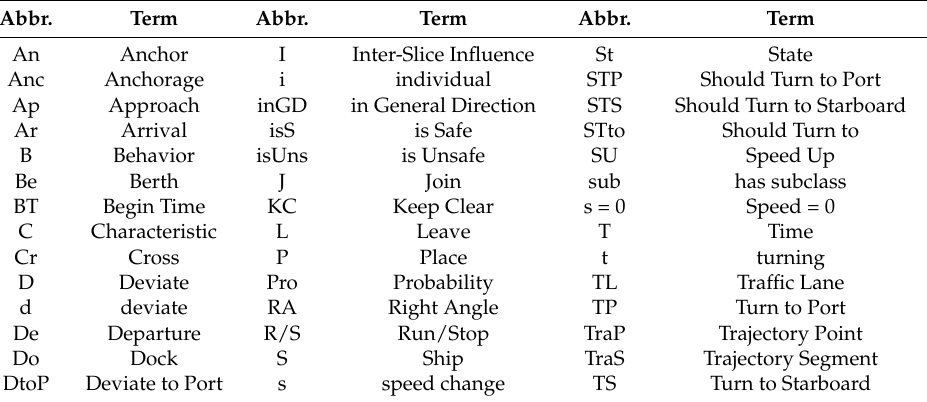
Table A1. Used abbreviations in this